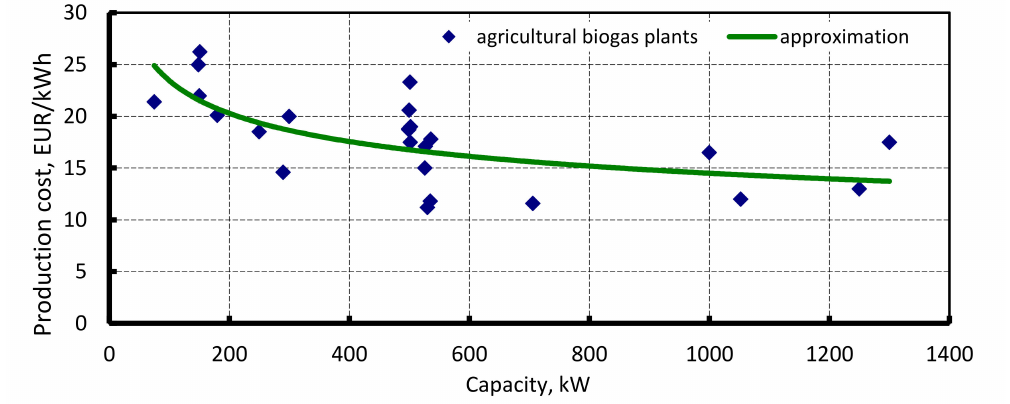
Figure 7. Electricity production costs versus installed